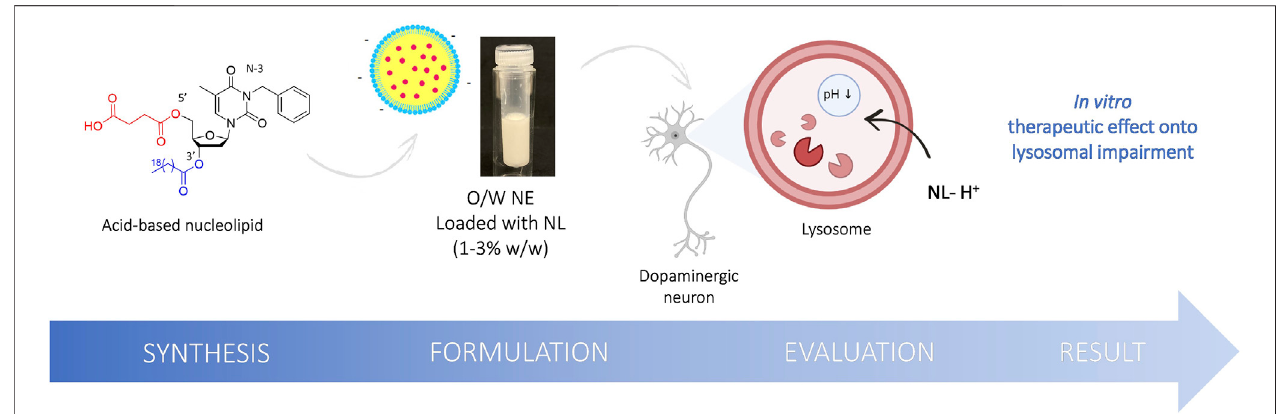
FIGURE1| SchematicillustrationofthestructureoftheoriginalNL8bearingsuccinicacidmoietyatthe5 ′ position,theformulationintoO/WNEandtheevaluation of the acidic NEs rescue lysosomal pH in vitro .